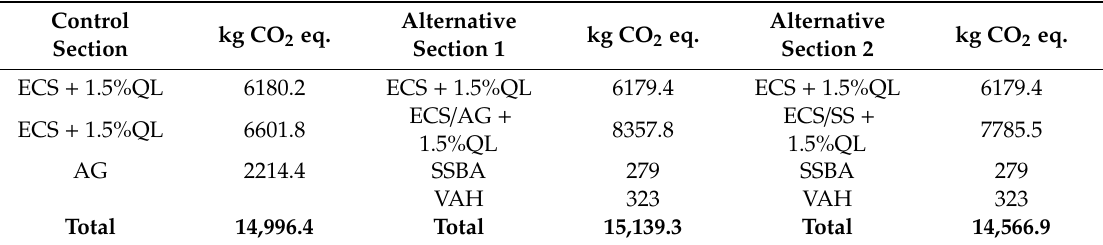
Table 10. Impact assessment values by layer component for GW category (kg CO 2